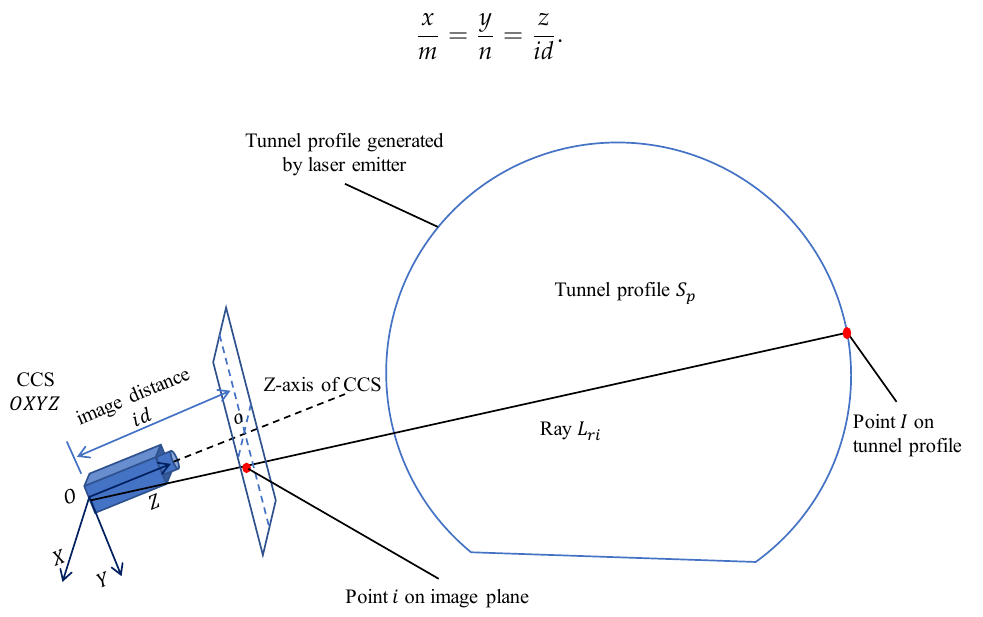
Figure 6. Transmissive projection of tunnel